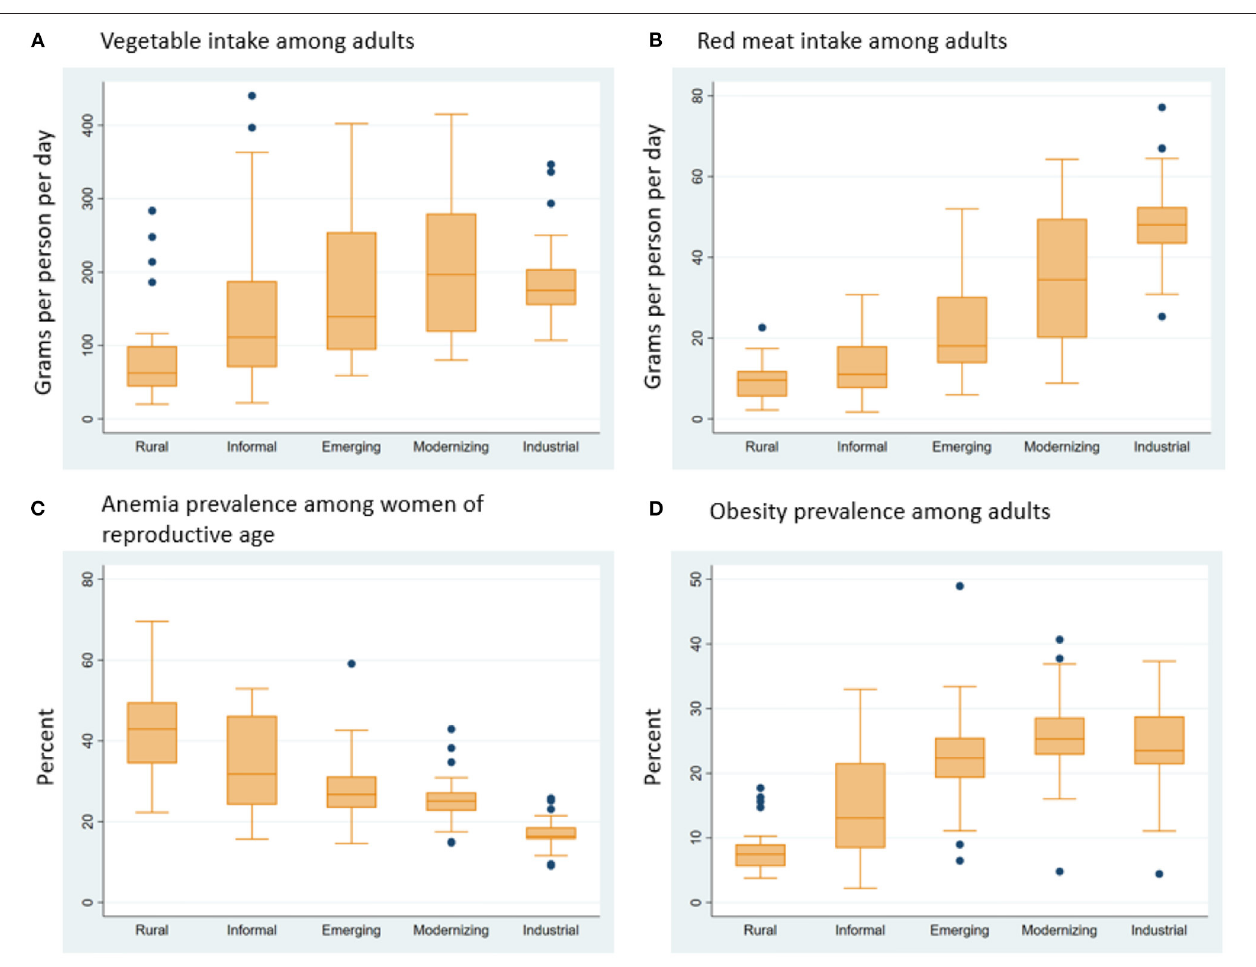
FIGURE 5 | Comparison of diet, nutrition and health outcomes across the food system